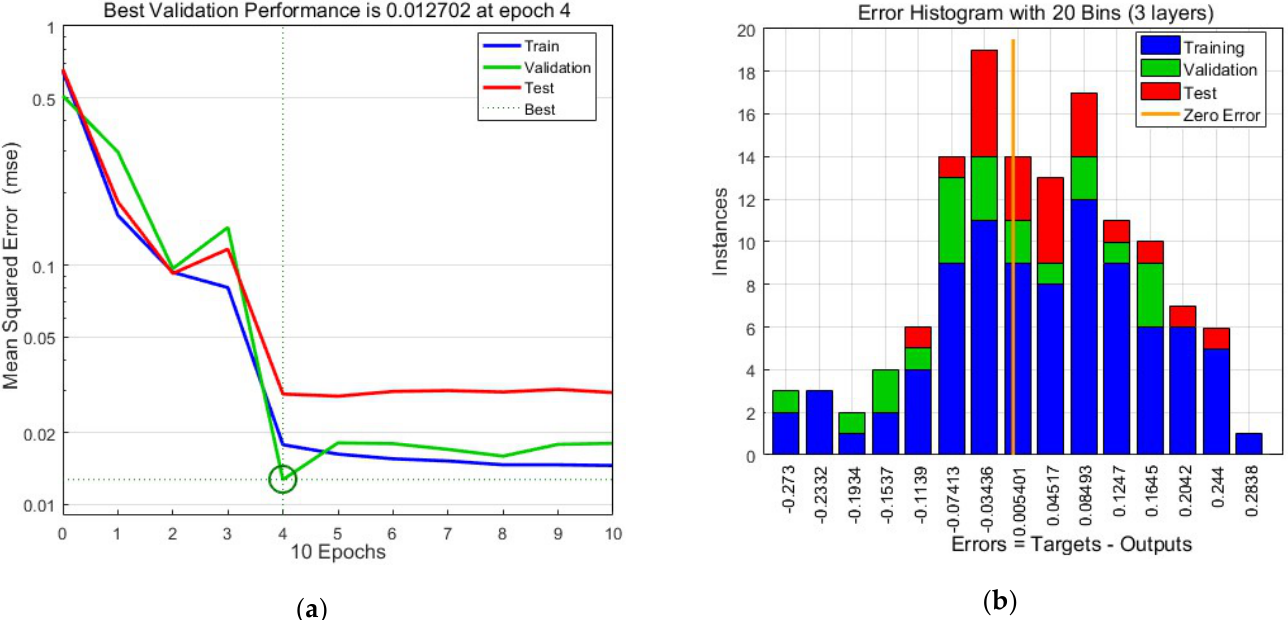
Figure 5. The plot, which indicates the iteration at which the validation performance reached a minimum ( a ) and histogram, which demonstrates scattering the output values the training, validation and testing sets of the delamination model for the drill Type 2 entry to the hole after four epochs ( b ). The training of these networks was carried out with the Levenberg–Marquardt back- propagation algorithm, which showed the best quality of training. After adjustments and retraining, all adopted versions of the networks were used to create the response surfaces for the delamination, which are shown in Figures 7 and